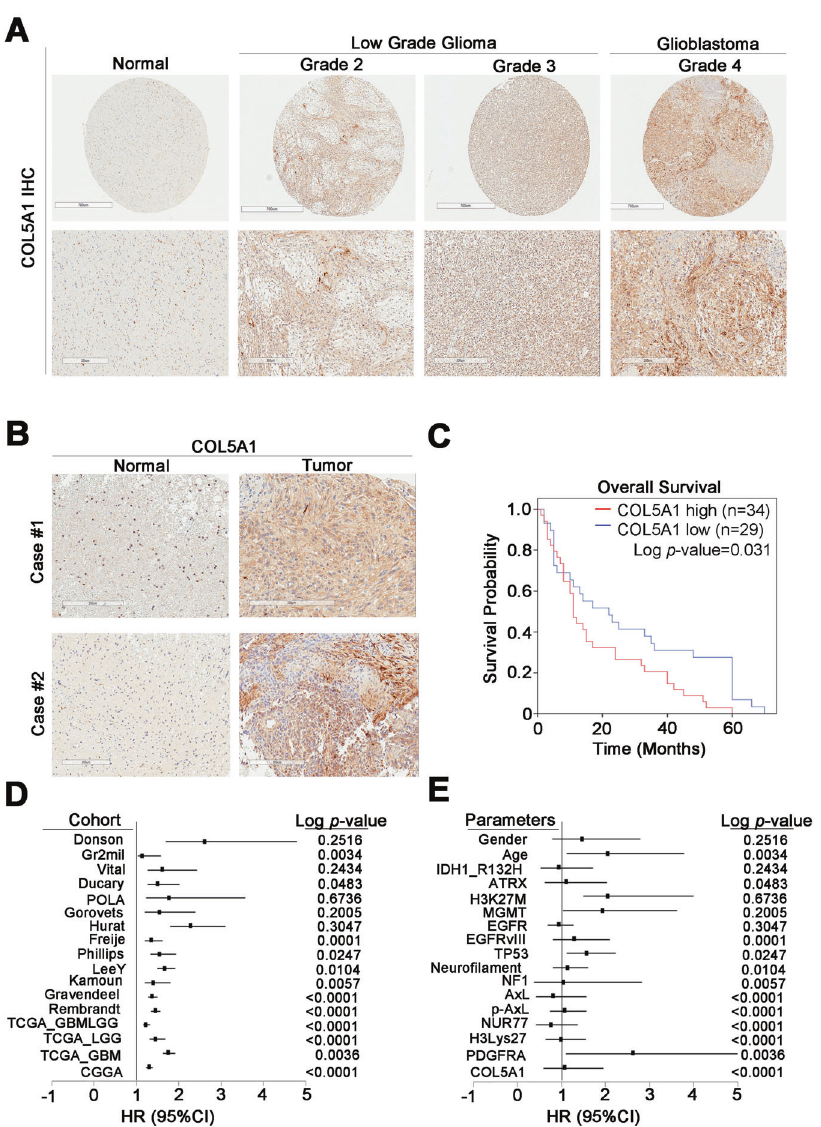
Fig. 2 Overexpression of COL5A1 correlates with poor survival in glioma patients. A Scores (0 – 3) indicate COL5A1 levels in representative glioblastoma tumor tissues. B Expression level of the COL5A1 protein in tumor tissue compared to that in corresponding normal adjacent tissue. C Kaplan – Meier overall survival curve of 63 glioma patients strati fi ed according to a high or low COL5A1 protein expression level ( p = 0.031). D A forest plot was generated with the hazard ratio and 95% con fi dence interval (CI) of the COL5A1 expression level in various clinical cohorts. E A forest plot was generated with the hazard ratio and 95% con fi dence interval (CI) of the COL5A1 expression level according to various clinicopathological factors in an existing cohort. The signi fi cance of the differences in ( C ) was analyzed using Student ’ s t